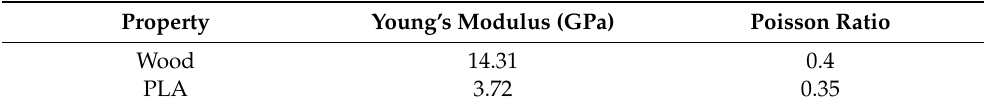
Table 1. Elastic properties of wood [39] and PLA